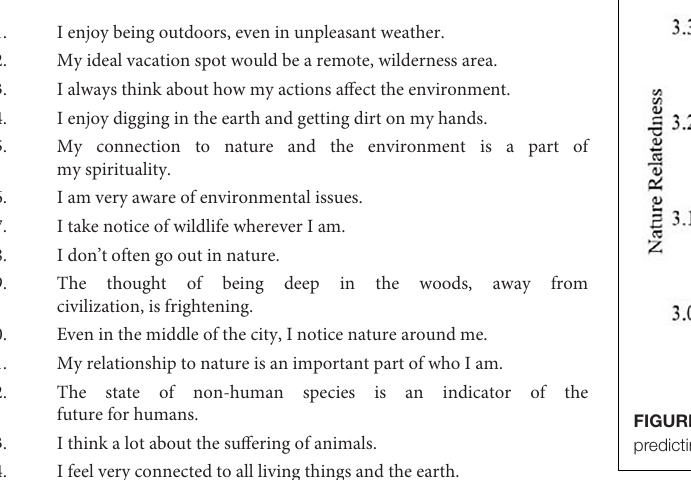
Table 2 for the effect of control variables (i.e., age, gender, and educational level).